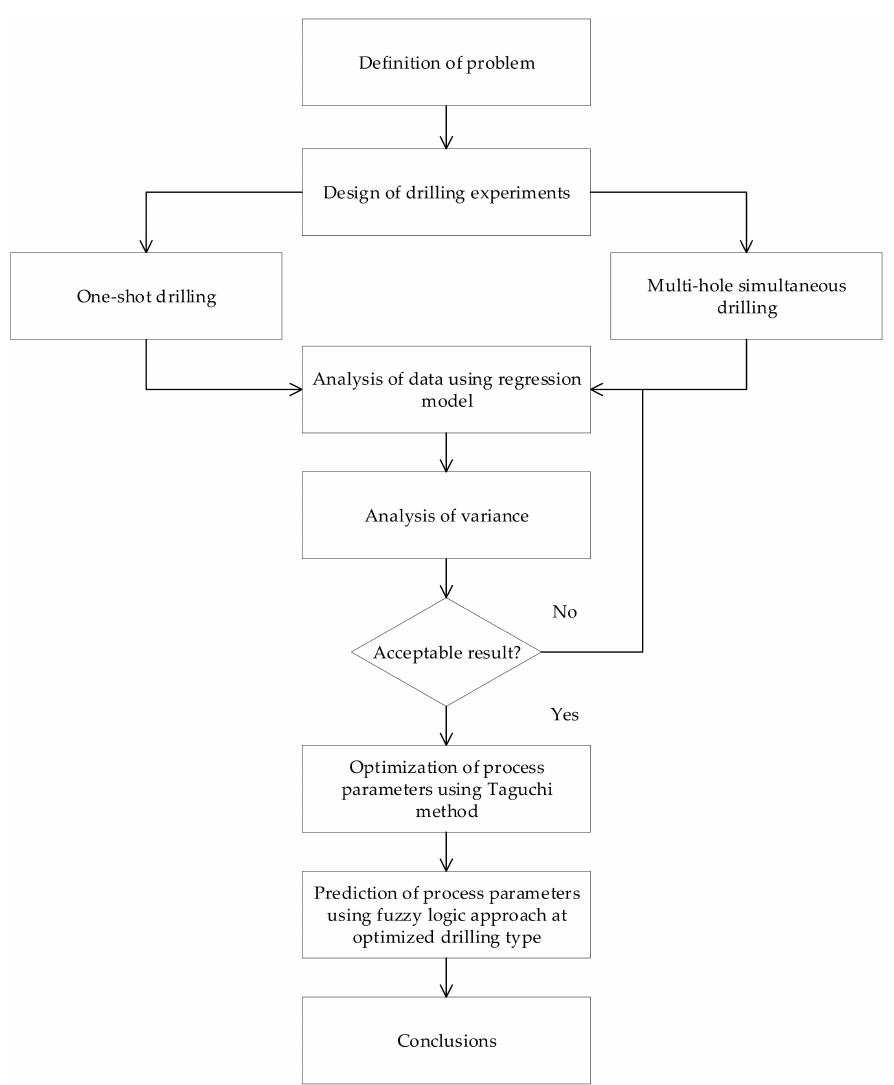
Figure 1. Layout for experimental